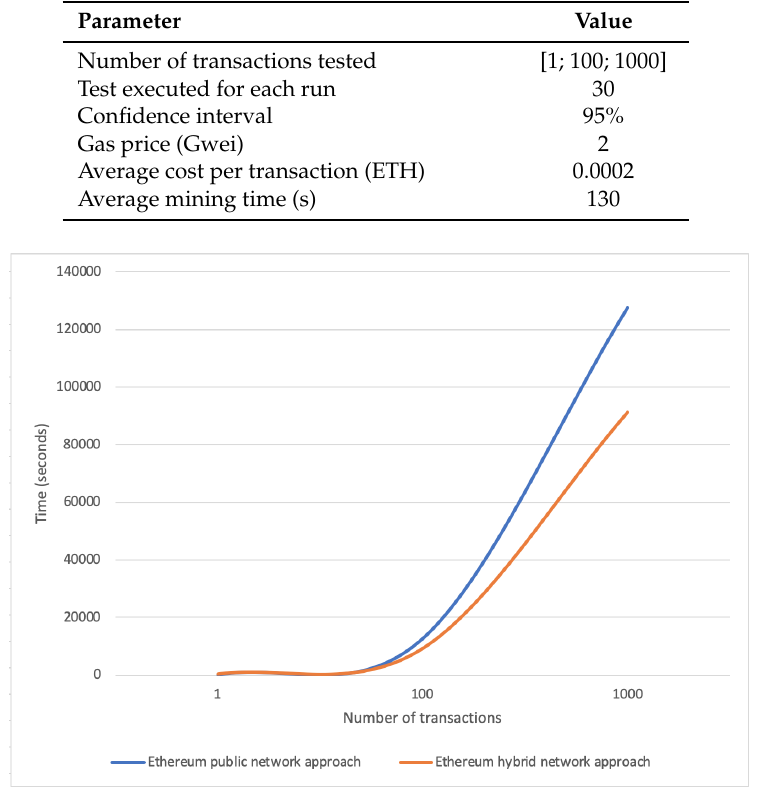
Figure 5. Time comparison for public and hybrid Ethereum network approaches considering a varying number of treatment registration